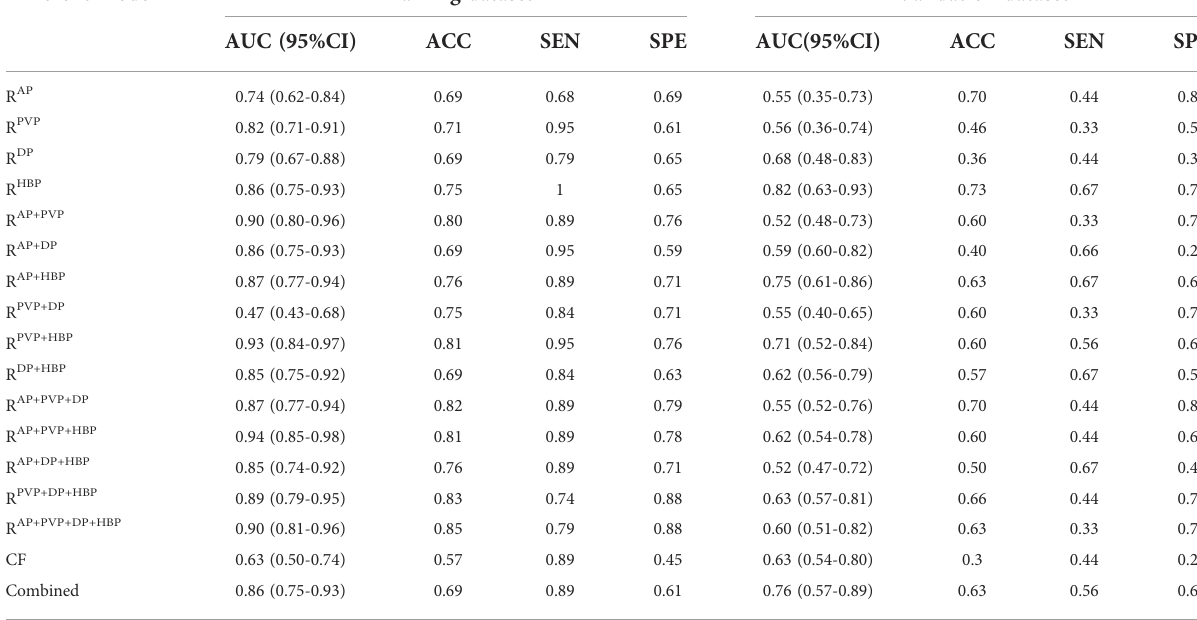
TABLE 4 Predictive performance of the proposed models. Different